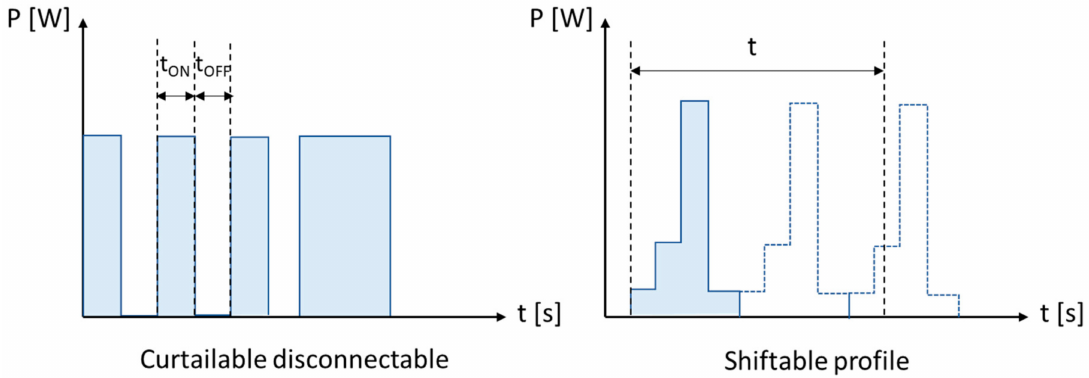
Figure 6. Examples of curtailable and shiftable